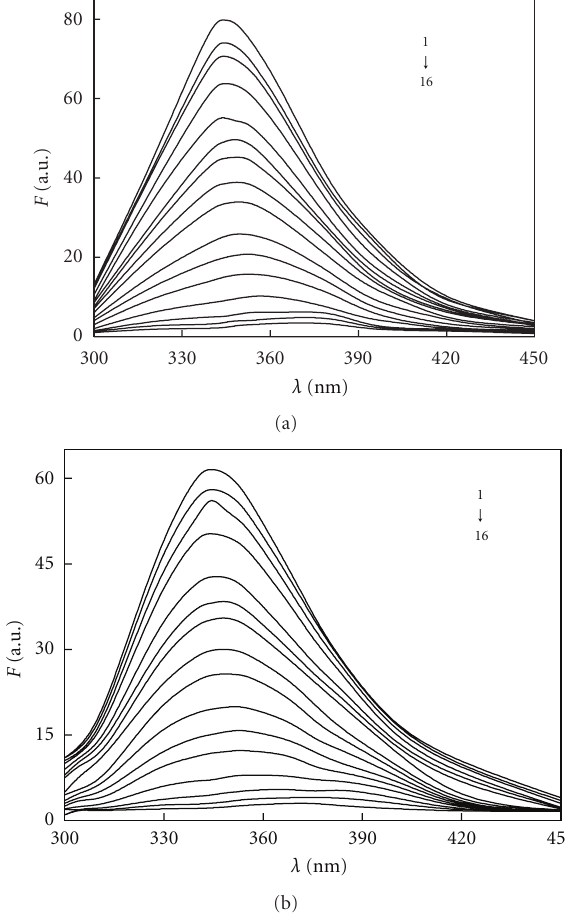
Figure 2: Fluorescence spectra of BSA-Avelox system. C BSA = 1.0 × 10 − 6 M, 1 ∼ 16; C Avelox = (0.0, 1.0, 2.0, 4.0, 6.0, 8.0, 10.0, 12.5, 15.0, 20.0, 25.0, 30.0, 40.0, 50.0, 60.0, 70.0) × 10 − 6 M; (a) λ ex = 280nm; (b) λ ex = 295nm; T = 293 K.